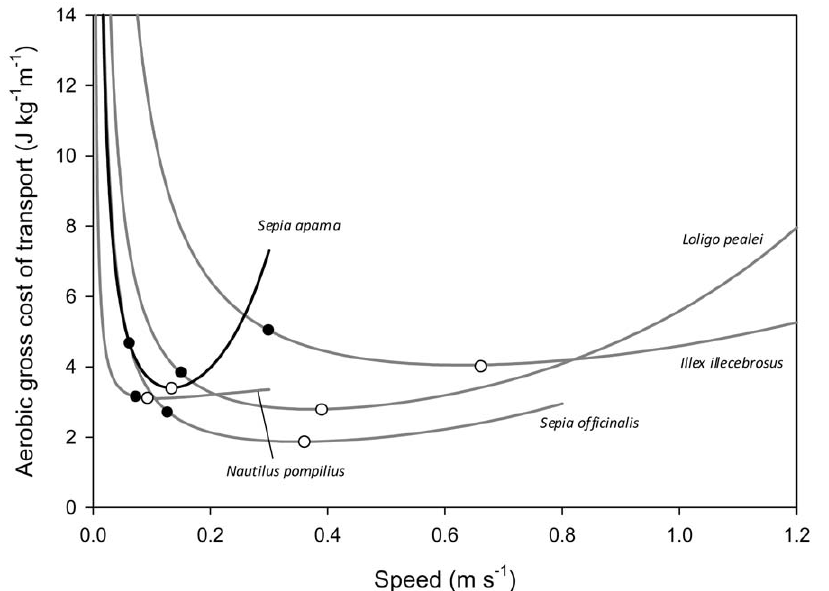
Figure 2. Estimated gross cost of transport in cephalopods, including the minimum cost (open circles) and actual tracked speeds (filled circles). Data for S. apama are derived from Equation 1 and tracked speeds in the field [21]. Data for other species are from O’Dor & Webber [17] and O’Dor [39].